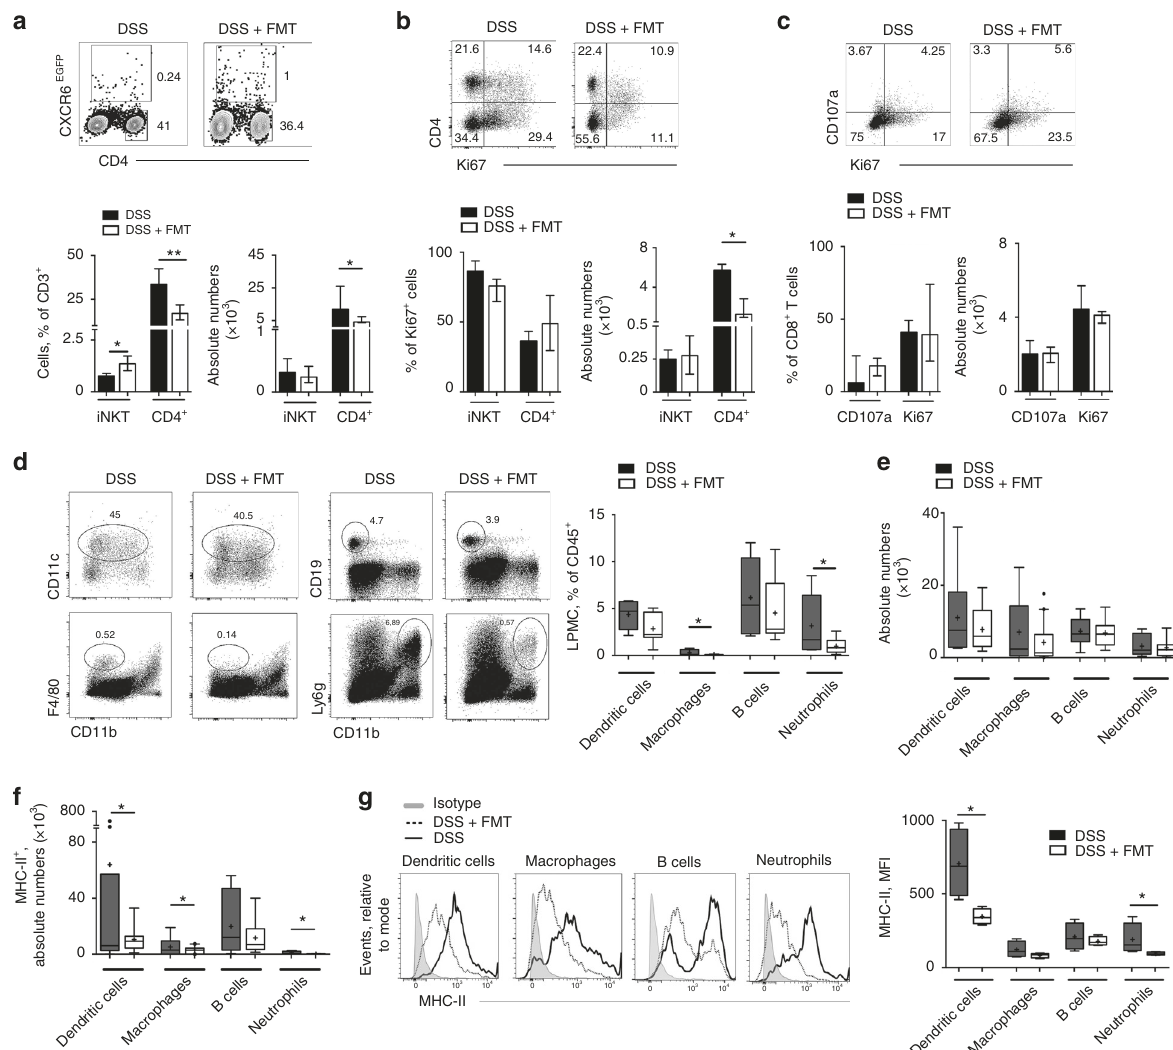
Fig. 5 Therapeutic FMT modulates immune cell frequencies and phenotypes. a Representative dot plots (upper panels), frequencies and absolute numbers (lower panels) of colonic CD4 + T cells and iNKT cells in DSS-treated (black bars) and FMT-treated (white bars) mice 11 days after starting DSS administration. b Representative dot plots, (upper panels), frequencies and absolute numbers (lower panels) of Ki67-expressing colonic CD4 + T cells and iNKT cells in DSS-treated (black bars) and FMT-treated (white bars) mice. c Representative dot plots, (upper panels), frequencies and absolute numbers (lower panels) of Ki67 and CD107a- expressing colonic CD8 + T cells in DSS-treated (black bars) and FMT-treated (white bars) mice. d Representative dot plots and frequency of dendritic cells (CD45.2 + CD3 - CD11c + ), macrophages (CD45.2 + CD3 - F4/80 + CD11b − ), B cells (CD45.2 + CD3 − CD19 + ), neutrophils (CD45.2 + CD3 − Ly6g + CD11b + ) in DSS-treated (left panels) and FMT-treated (right panels) mice 11 days after starting DSS administration. e Absolute numbers of colonic dendritic cells, macrophages, B cells, neutrophils in DSS-treated (black boxes) and DSS + FMT-treated (white boxes). f Absolute numbers of MHC-II expressing colonic dendritic cells, macrophages, B cells and neutrophils in DSS (white boxes) and DSS + FMT-treated (black boxes) mice. g Representative histograms of MHC-II expression and cumulative Mean fl uorescence intensity (MFI) on colonic dendritic cells, macrophages, B cells, neutrophils in DSS (black boxes) and DSS + FMT (white boxes) treated mice. Statistical signi fi cance was calculated using a Mann – Whitney test for comparison within two groups or Kruskal – Wallis test with Dunn ’ s multiple comparison correction within more than two groups. * P < 0.05, ** P < 0.01, *** P < 0.001 were regarded as statistically signi fi cant. Outliers were detected with Grubb ’ s test. Non parametric distributions were represented as median + /- interquartile range. In Box and whiskers plots, centre line represents median; cross, represents mean; dots represent outliers. In ( a – c ) DSS n = 12, DSS + FMT n = 12. In ( d – g ) DSS n = 16, DSS + FMT n =